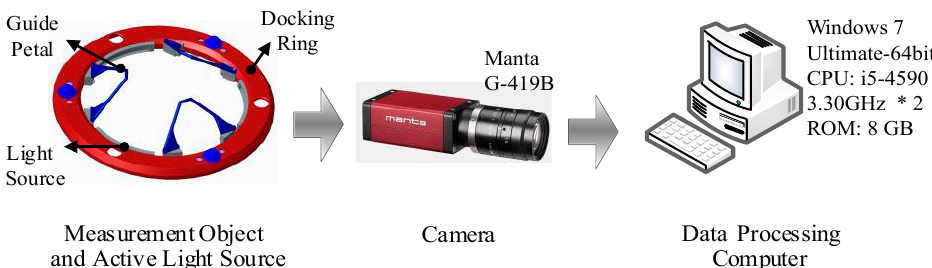
Figure 2. The framework of the monocular vision system.